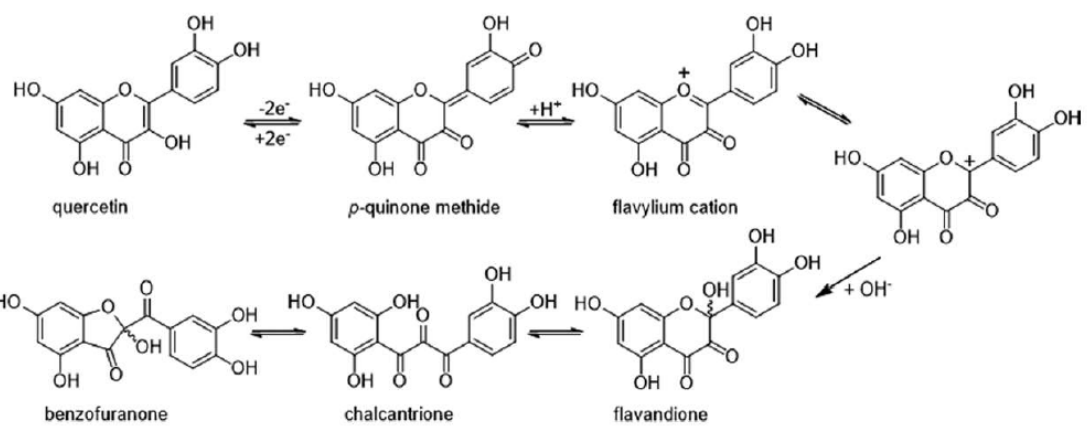
Figure 2. Sequence of chemical structures and reactions proposed to be involved in the oxidative conversion of quercetin into Q-BZF (Reproduced with permission from [57], Copyright © 2017 American Chemical Society).